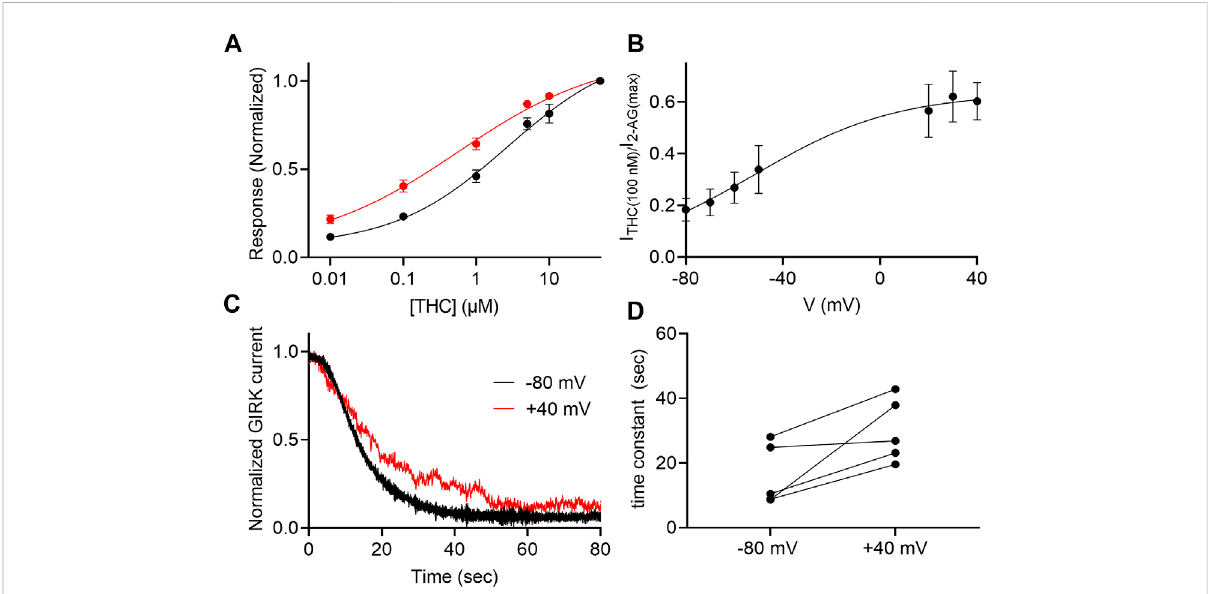
FIGURE 5 Voltage dependence of the potency of THC. (A) Dose response curves for several THC concentrations at − 80 mV (black symbols and line; n = 29,29,29,13,12and30for1,10,100,1,000,5,000,10000,and50000 nM,respectively)andat+40 mV(redsymbolsandline; n =18,18,18,14,8and 21 for 1, 10, 100, 1,000, 5,000, 10000, and 50000 nM, respectively). The responses are normalized to the response evoked by 20 µM THC at each holding potential. (B) The dependence of the relative activation of the receptor by 100 nM THC in voltage. Responses are normalized to the response evoked by 50000 nM THC at each holding potential. (C) A comparison of the decay of GIRK currents at -80 mV (black) or at +40 mV (red). The washout of the agonists took place at time 0 and the currents were normalized to enable comparison between the two recordings. (D) Time constants of decay measured of − 80 mV and +40 mV. Each two data points connected with a line represent the same oocyte at the two holding